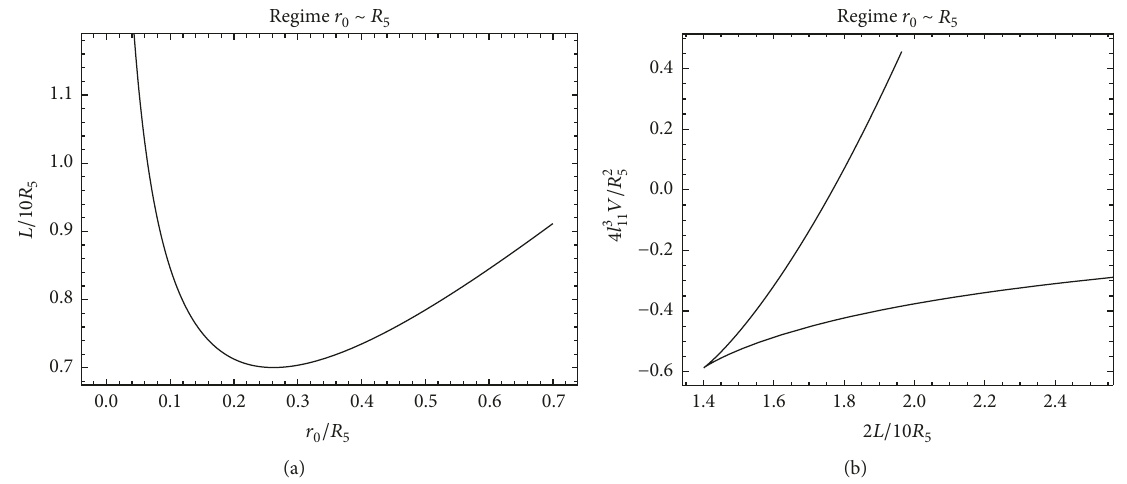
Figure11:DistanceandpotentialinM5branespace.(a)Distance 𝐿/𝑅 5 betweenquarksversus 𝑟 0 /𝑅 5 .(b)Potentialinteraction 𝑙 3 11 𝑉/𝑅 2 5 between quarks versus 𝐿/𝑅 5 . Here, in both panels 𝑟 1 /𝑅 5 = 10 2 , 𝑟 0 /𝑅 5 < 0.8 , and 𝑟 ∗ /𝑅 5 = 0.26 .